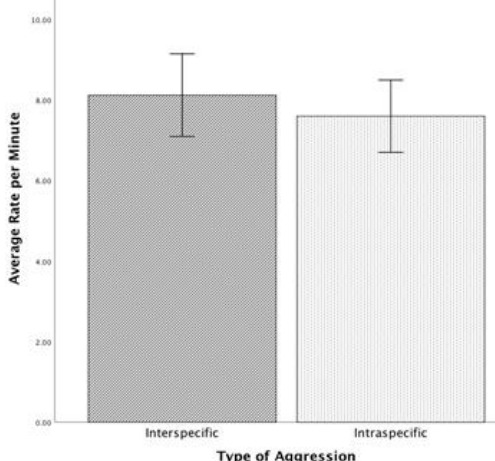
Figure 2 Average rate per min for all Behavioral Events Combined During the Encounters for both Intraspecific and Interspecific Aggression